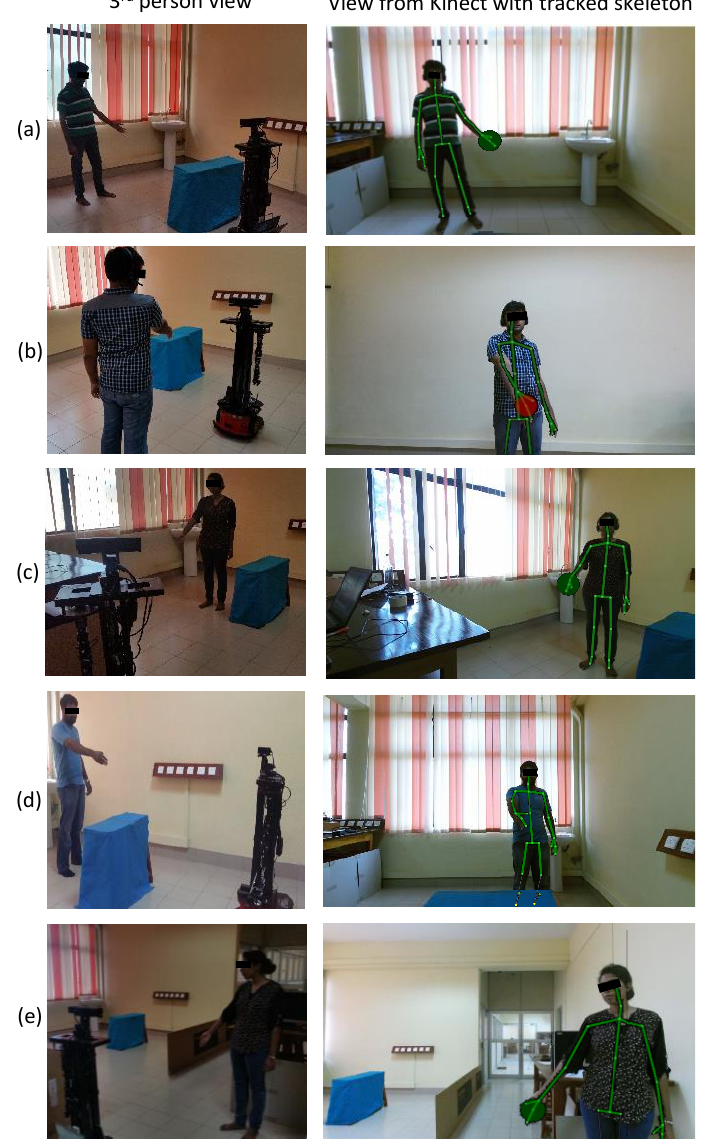
Figure 6. The view of the robot and the third person view of sample scenarios are shown with the corresponding case ( a – e ) given in Table 2. The tracked skeletons of the users are also superimposed with the RGB view of the robot for better